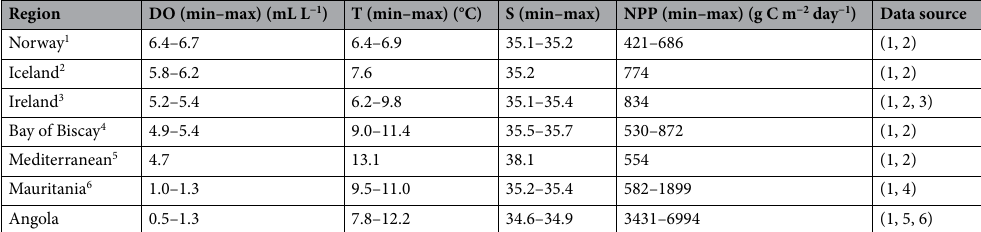
Table 6. Environmental envelop of geographical areas where Madrepora oculata data on occurrence, density and/or coverage as well as growth rates have been published or are included in this work (Angola). DO dissolved oxygen, T temperature, S salinity, NPP net primary production. 1: Norwegian mid-shelf break, Træna (~ 67° N, 11.1° E), Røst (~ 67.5° N, 9.4° W), and Sotbakken (70.8° N, 18.7° W) reefs; 2: southern Iceland